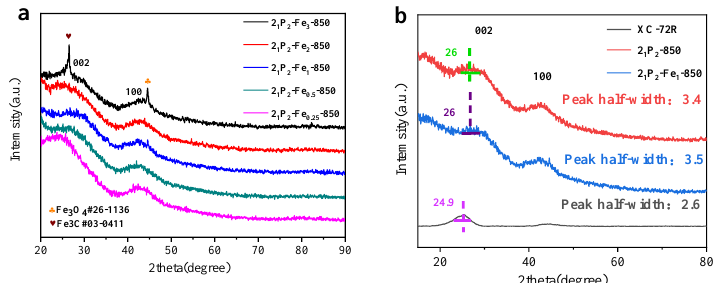
Figure 5. ( a ) XRD pattern of 2 1 P 2 -Fe x -850 series catalyst and ( b ) comparative XRD plots of catalysts XC-72R, 2 1 P 2 -850, and 2 1 P 2 -Fe 1 -850.